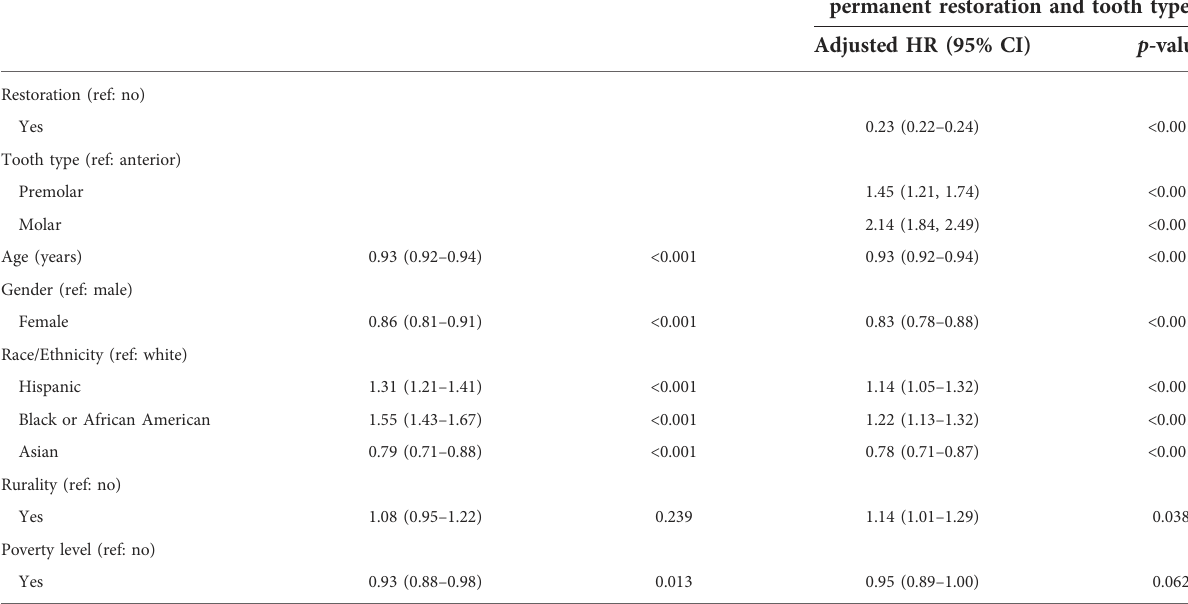
TABLE 4 Adjusted hazard ratio (HR) estimates for the effect of demographic covariates on occurrence of untoward event from multivariate cox proportional hazard analysis (covariate “ DHPSA ” excluded from model after backward variable selection). Adjusted HR (95% CI) p